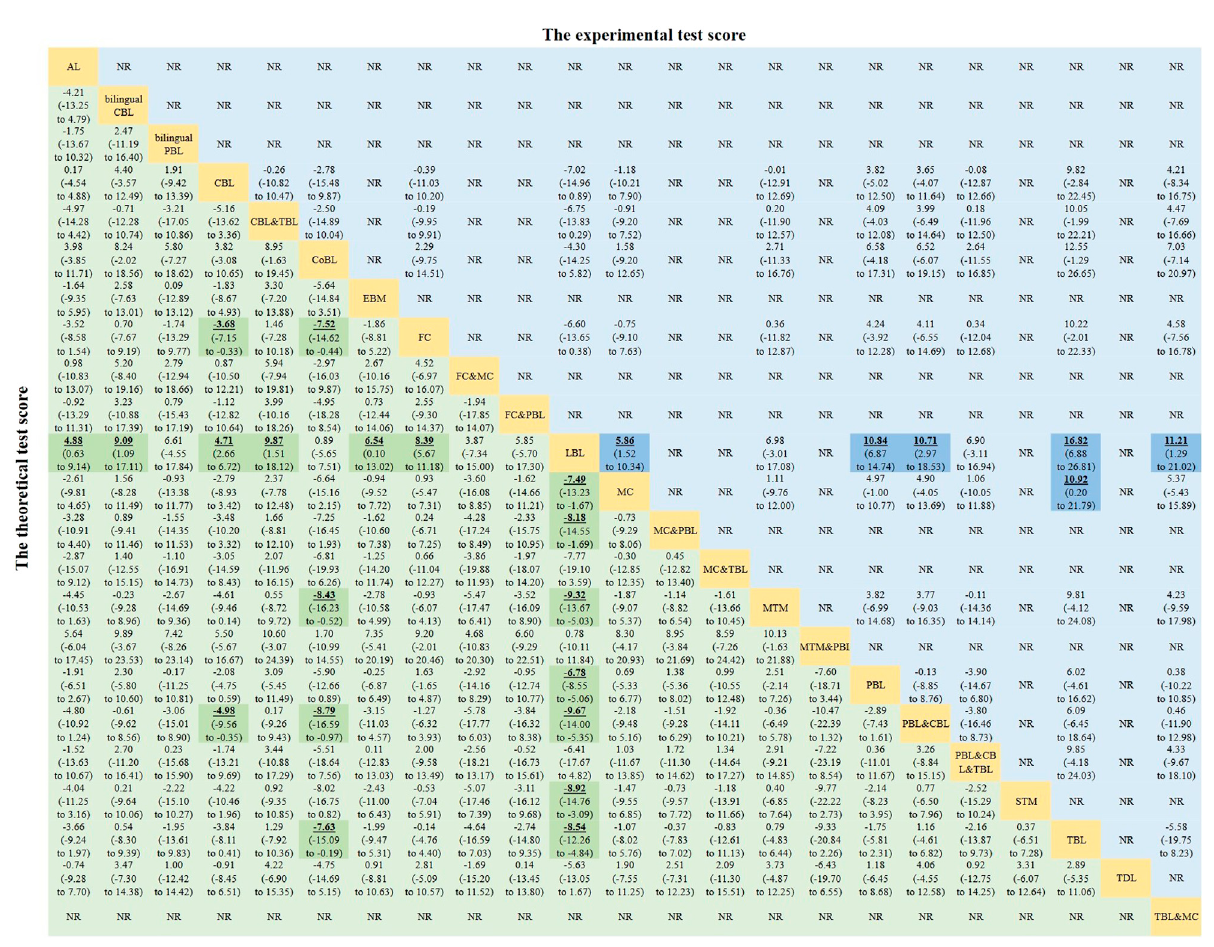
FIGURE 4 Meandifferencesofthetheoreticaltestscore(lowertriangle)andtheexperimentaltestscore(uppertriangle).Datawithmeandifferencesrepresent the comparison of row-de fi ning method versus column-de fi ning method. Data in parentheses are the 95% credible intervals. Mean differences more than zero favour the column-de fi ning method. Signi fi cant results are highlighted in bold, underline, and background fi ll. NR represents this indicator was not reported in this method among the included